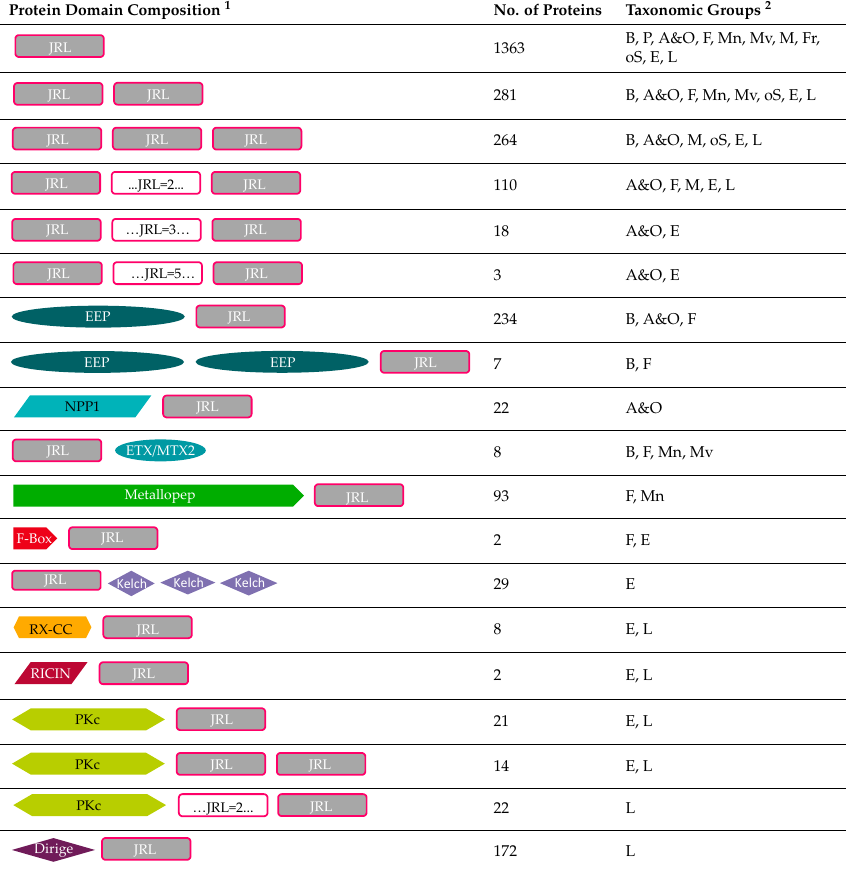
specific for different taxonomic groups. In Table 1 we present schematic drawings of these domain compositions encompassing the most prevalent chimeric JRL-proteins along with the total number of these proteins, as found in the previously-performed conserved domain search for the JRL domain containing proteins identified in the Uniprot query, and the taxonomic groups in which they occur. Table 1. Domain composition of most prevalent single-domain and chimeric JRL proteins and their occurrence in different kingdoms and taxa. Domains were identified using NCBI Batch Web CD- Search Tool. Proteins with domain compositions occurring in more than one taxonomic group or in more than 20 proteins out of 3000 JRL domain (PF01419) containing proteins were identified with UniProt. Column one shows the protein domain composition. Columns two and three show the number of proteins (No. of proteins) with depicted domain composition and their occurrence in different taxonomic groups (Taxonomic groups).